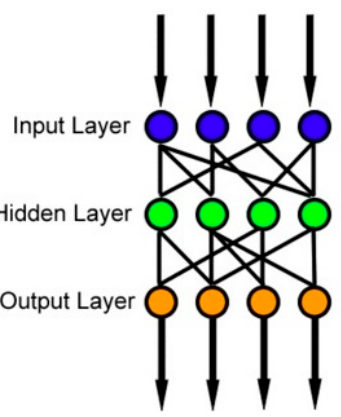
Figure 1. A general scheme of the three-layer network with one hidden